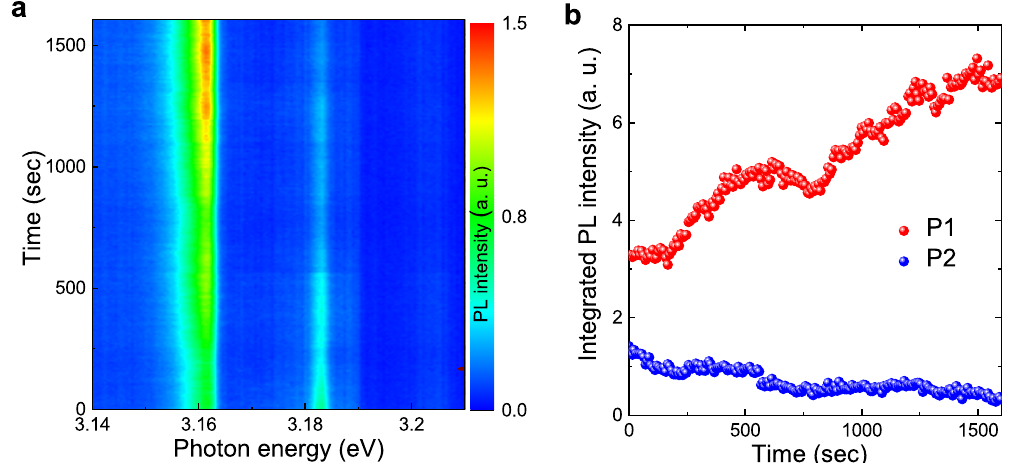
Fig. 2 Temporal variation photoluminescence. a Temporal variation of the PL spectra measured at 4.2 K. b The integrated PL intensity as a function of time. The red and blue dots relate to emission from P1 and P2, respectively. The peak intensity was extracted by Gaussian fi